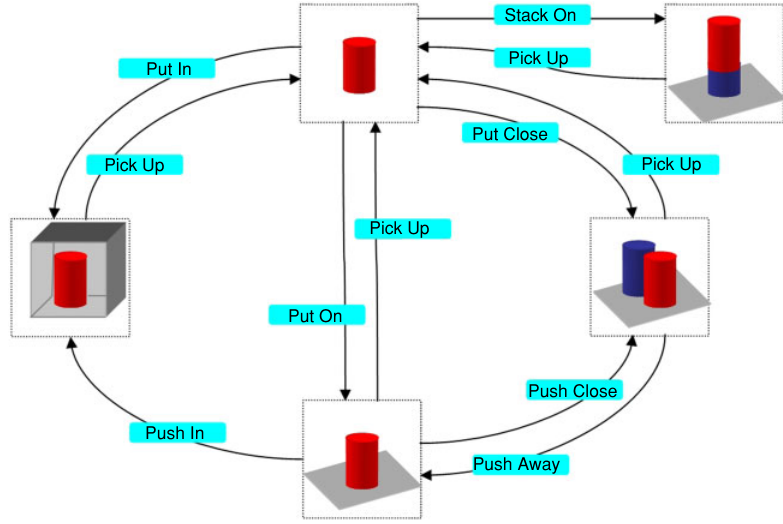
Figure 6 A FSM representation for the set of possible actions on the object “Cylinder”. Table 1 The difference of the body schema and body percept for